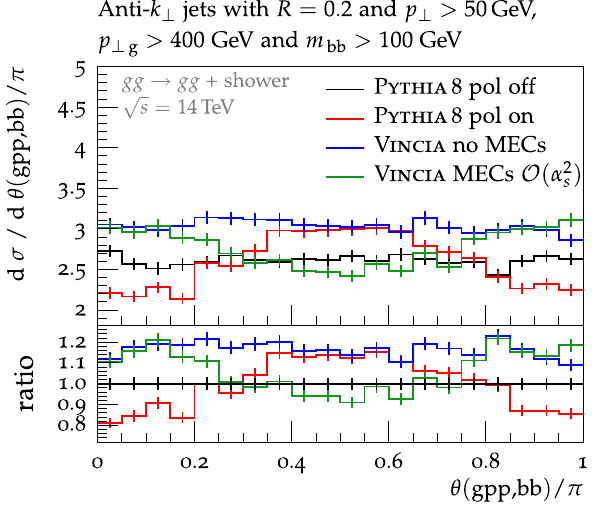
Fig. 3 The angle between the plane of the two b -jets and the plane of the gluon jet and the beam axis. Predictions of Pythia 8.2.26 and Vincia 2.2.0 with and without ME corrections are shown. In the labelling, “pol off” refers to the Pythia 8 parameters TimeShower:phiPolAsym and TimeShower:phiPolAsymHard being switched off and “pol on” to the default settings, where both parameters are switched